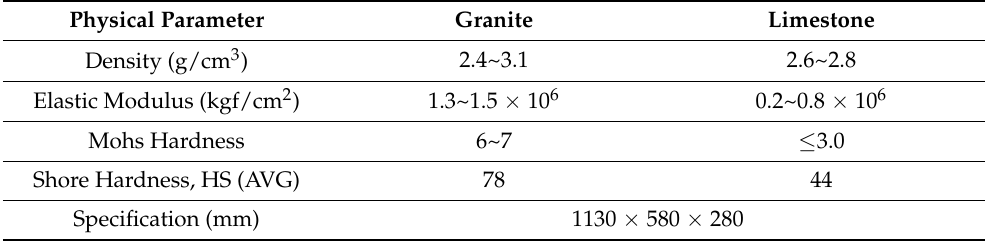
Figure 2. 19 in. single-edged disc cutter used in the test: ( a ) 3 types of single-edged disc cutters; ( b ) judgment criteria for cutter wear failure, radial limit wear 35 mm. Table 2. Physical parameters of rock samples.